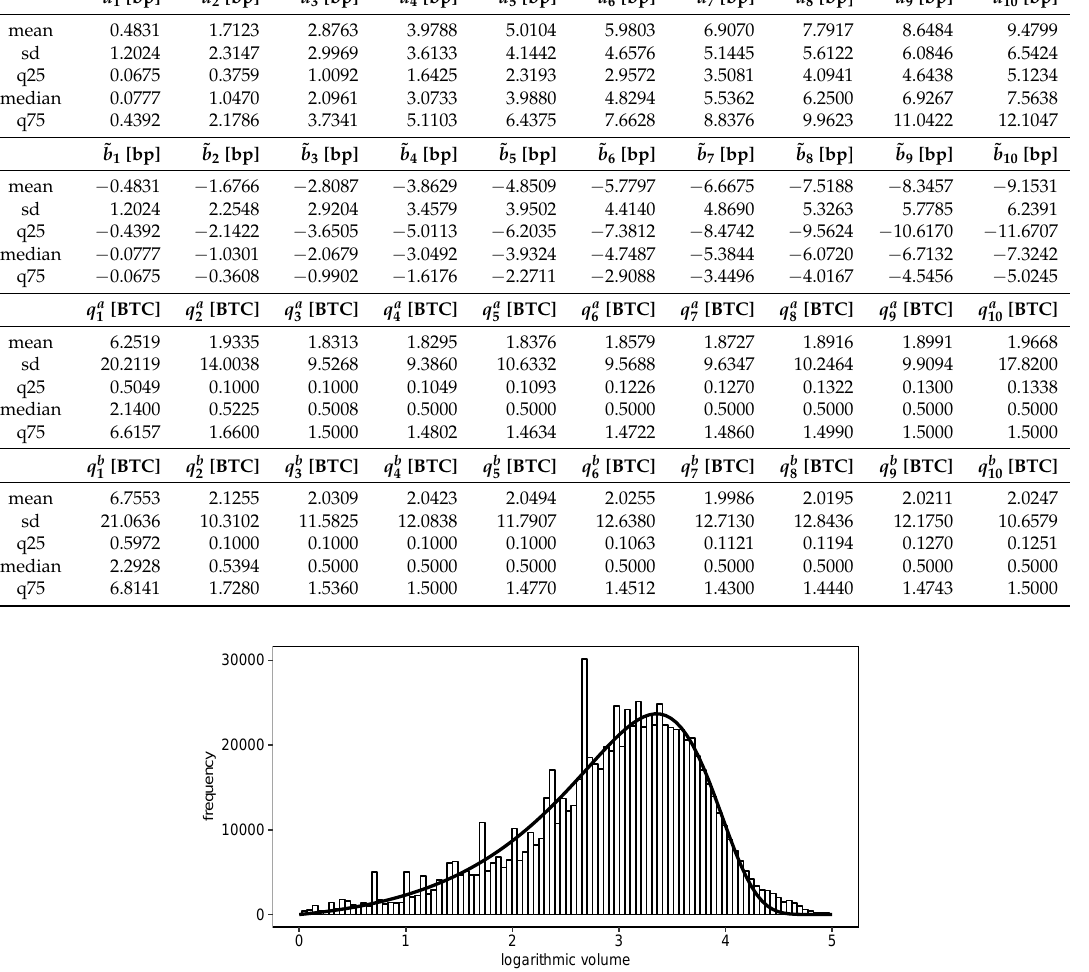
Figure 3. Distribution of volume at the best bid and best ask. We plot the empirical distribution of the common logarithm of the volume at the best bid and ask in units of the minimum order size (0.002BTC). The solid line corresponds to a fit of a Gamma distribution with γ ≈ 0.28 and θ ≈